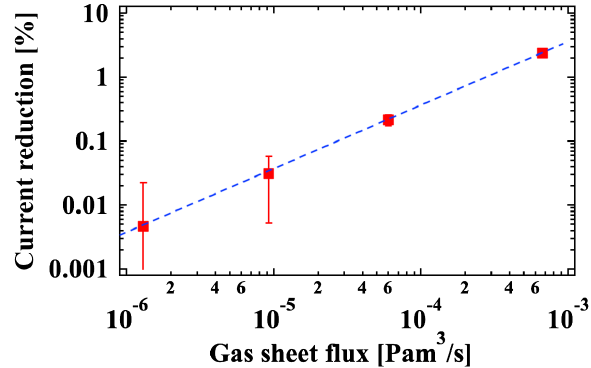
FIG. 16. The beam current reduction due to the gas injection measured by current transformers. The error bars describe the deviation of the current reduction. The blue broken line is the fitted line to a linear function.